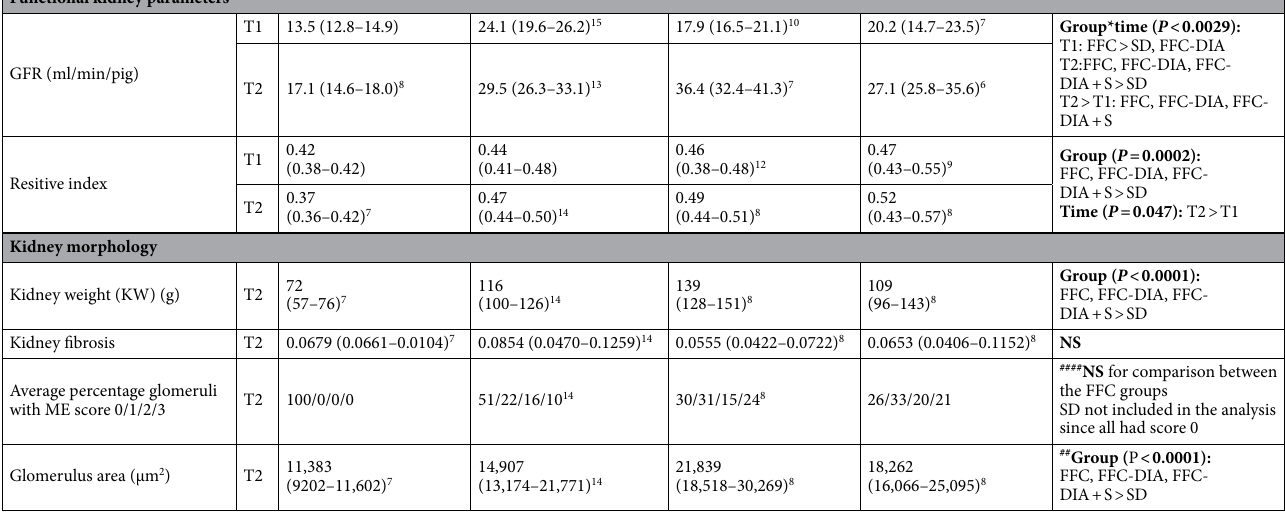
Table 3. Kidney functional and morphological changes in castrated male Göttingen Minipigs fed with standard diet (SD) or fat, fructose and cholesterol rich diet (FFC) with or without additional salt (S) and with or without streptozotocin-induced diabetes (DIA). GFR: glomerular filtration rate, FFBM: fat-free body mass, KW: kidney weight. T1: Approx. 7 months of diet-feeding, T2: Approx. 13 months of diet feeding. Median and interquartile range (Q1-Q3). Superscript: Actual numbers included in the statistical analysis due to missing data. P-values from post hoc tests were adjusted using Bonferroni correction. ## Non parametric test, ### Two- sided analysis of variance, #### Proc